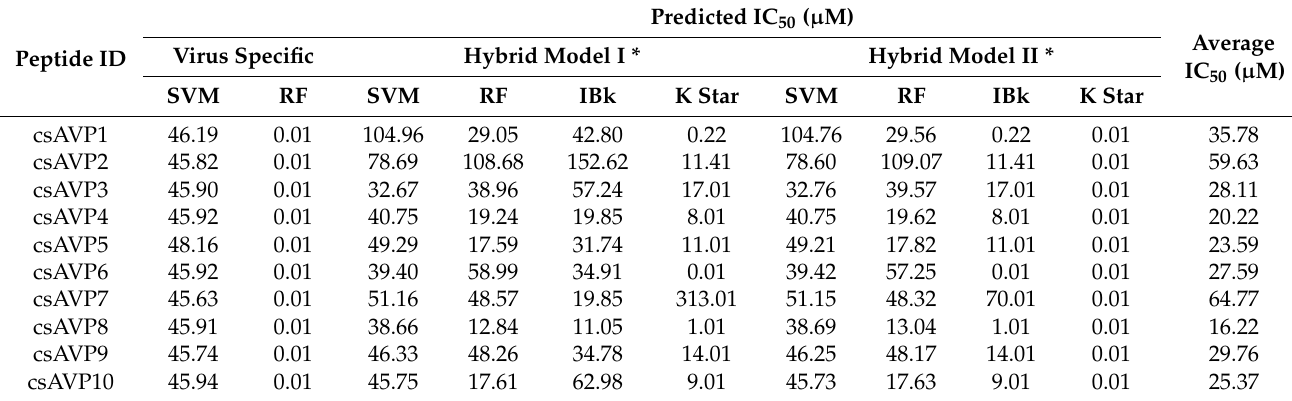
Table 2. Predictive AVP half maximal inhibitory concentration (IC 50 ) by SVM, RF, IBk, and K Star- based models from the AVP-IC 50 Pred webserver.